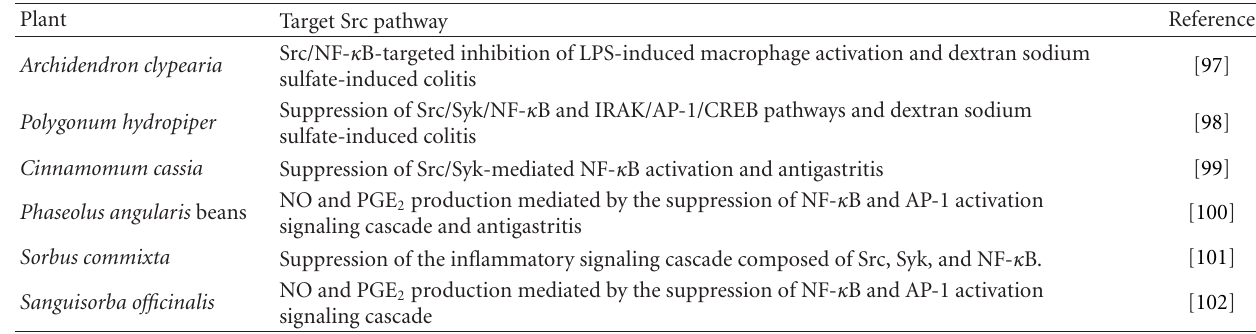
Table 4: Plant extracts inhibiting Src activation in macrophages.